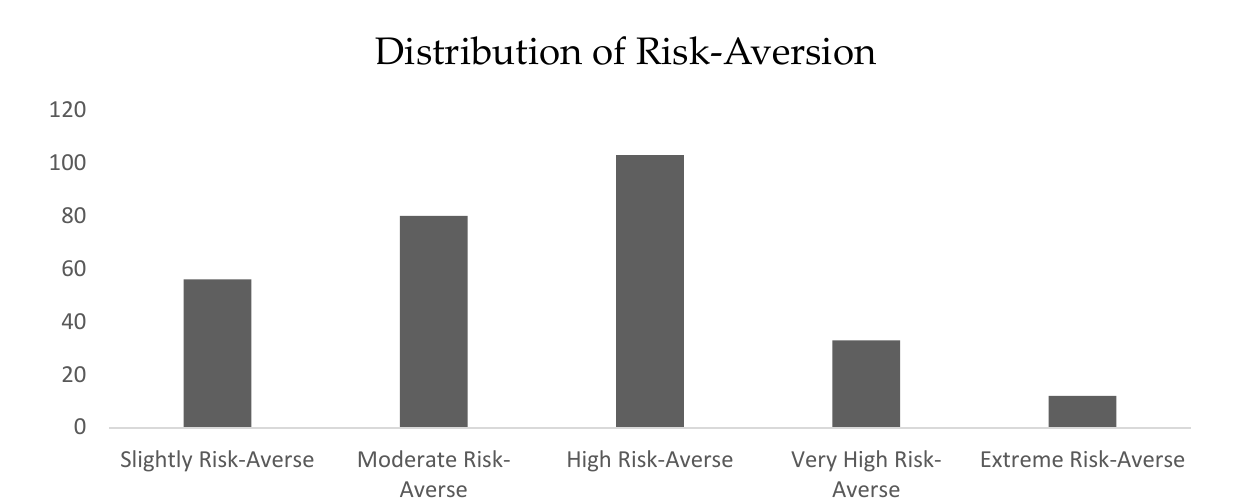
Figure 4. Distribution of Risk-Aversion in the Study Area.